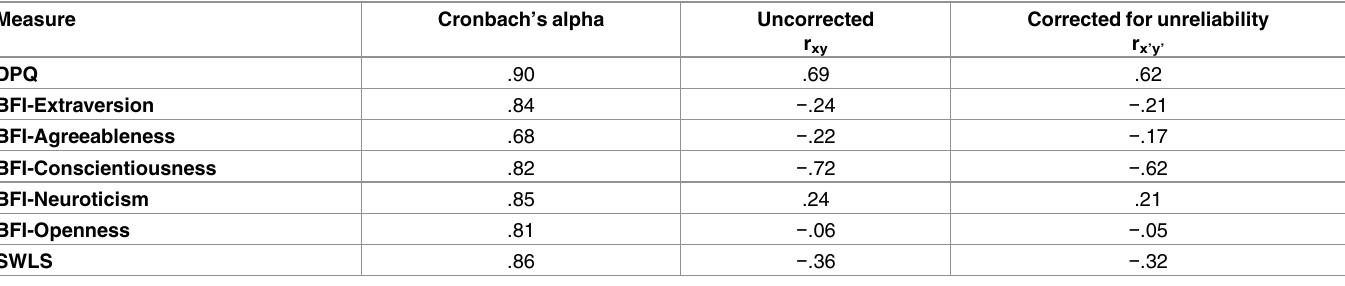
Table 4. Internal consistency and correlations between the IPS and other measuresof procrastination, personality traits and satisfaction with life.